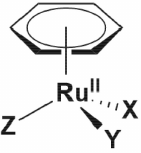
Figure 9. Representative ‘piano stool’ Ru II - η 6 –arene complex, where X, Y, and/or Z is a labile ligand.